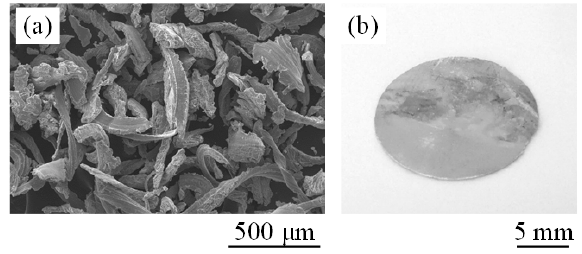
Figure 1. ADC12 burrs ( a ) in powder form and ( b ) in round-plate form.